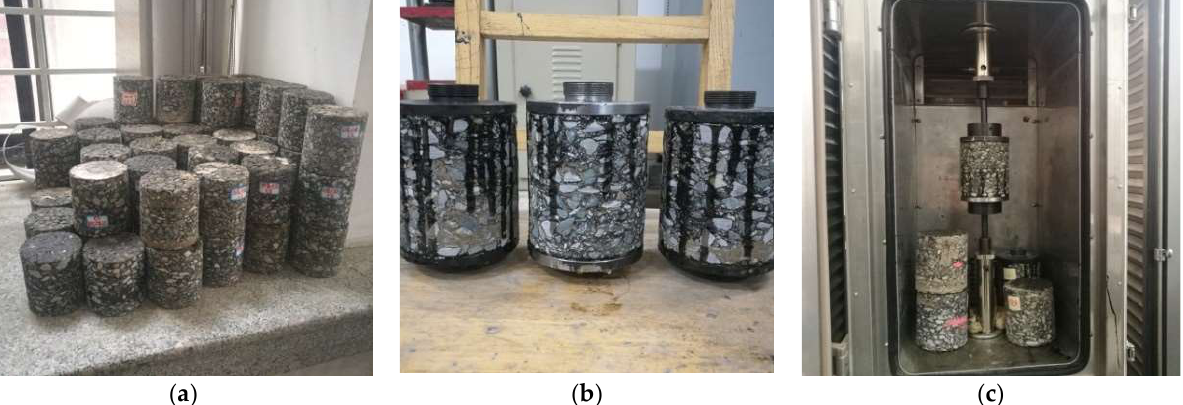
Figure 9. Specimens of bonding materials used for test analysis: ( a ) shaped specimens; ( b ) installation of tensile specimens; ( c ) specimens kept in the environmental chamber.